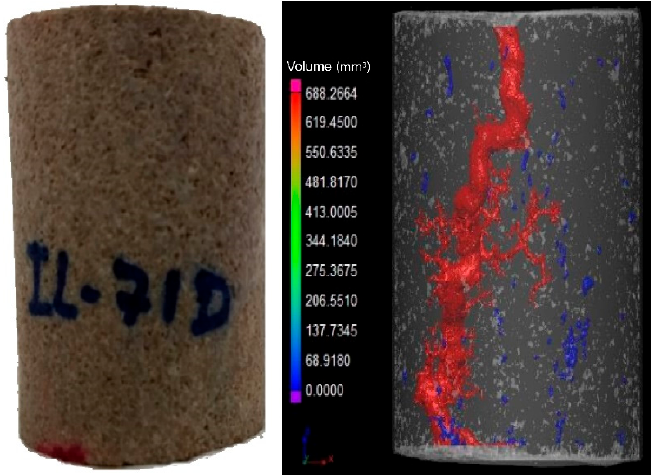
Figure 3. Imaging of wormhole structure using CT scan; ANS1; 0.5 mL/min (IL-71D).